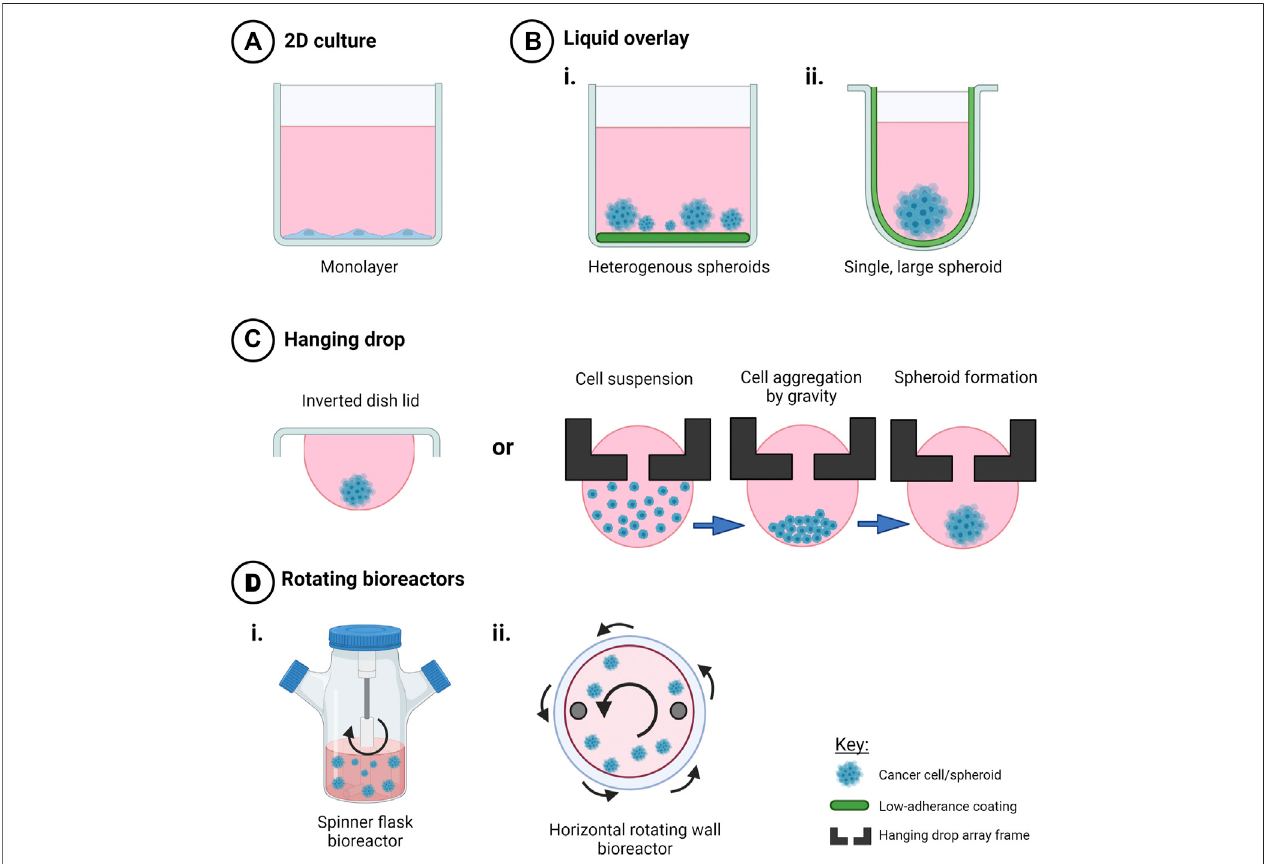
FIGURE 2 | Techniques to create scaffold-free 3D in vitro cancer models. Creation of 3D cell models in the absence of scaffolds promotes cell-cell interactions in three dimensions that mediate cell behavior and drug response when compared to (A) 2D monolayers. Use of (B) liquid overlay techniques with i) fl at or ii) round- bottomed ULA plates (C) , hanging drop techniques and (D) rotating bioreactors such as i) spinner fl asks and ii) horizontal rotating vessels have been used as time and cost-effectivespheroidcreationmethods ortoinvestigatedrugresponseandotherfactorsthatmyin fl uenceovariancancerprogression,suchas fl uidshearstress and hypoxia. Created with